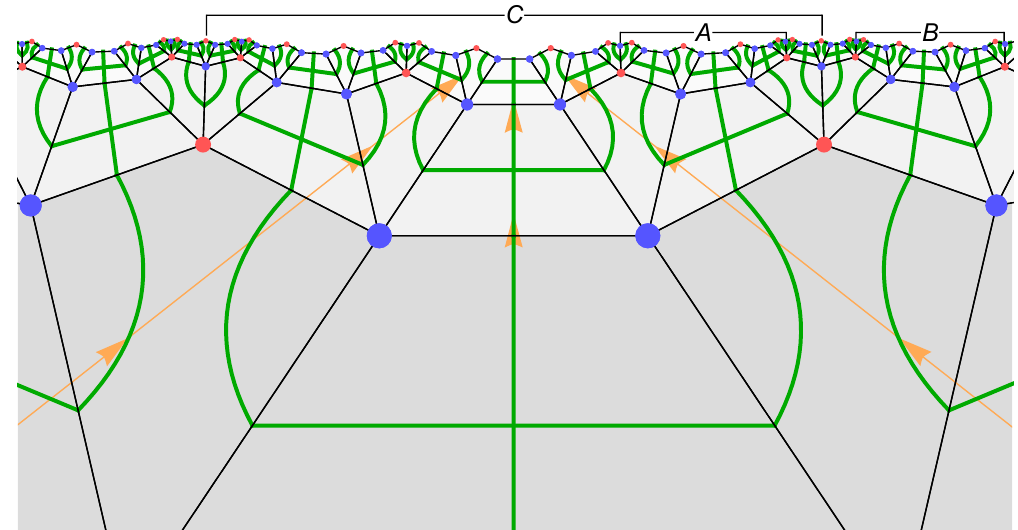
Figure 14: Tensor network reproducing the ground state of the { 4,5 } aperiodic XXX chain, embedded onto the corresponding regular tiling. We zoom in on a part of the TN close to the boundary of the tiling, allowing us to leave unspecified the foliation used to define the inflation. The orange arrows are the same as in Fig. 13. The portions of tensor networks ending on the boundary subregions A and B are related by the local translational symmetry. Moreover, they are both related to the portion of the network ending on the boundary subregion C by a local scaling